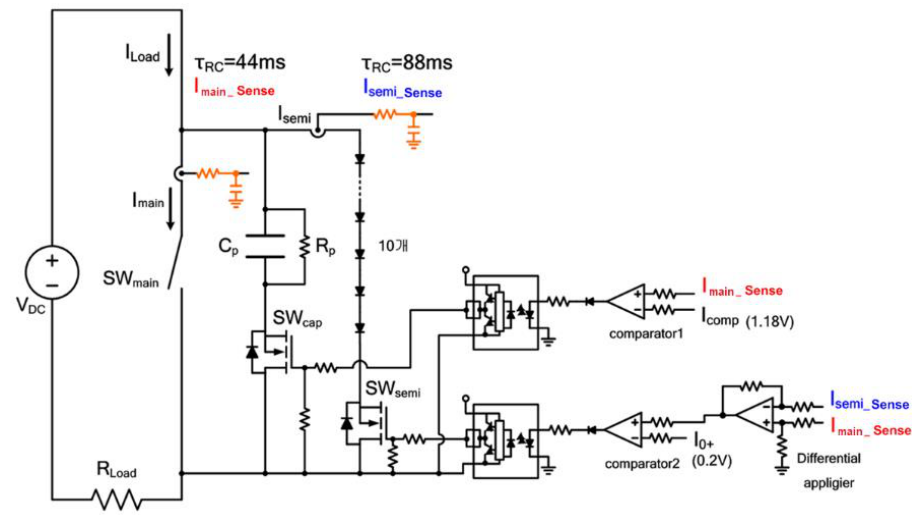
Figure 4. Experimental circuit of the proposed MVDC hybrid circuit breaker.